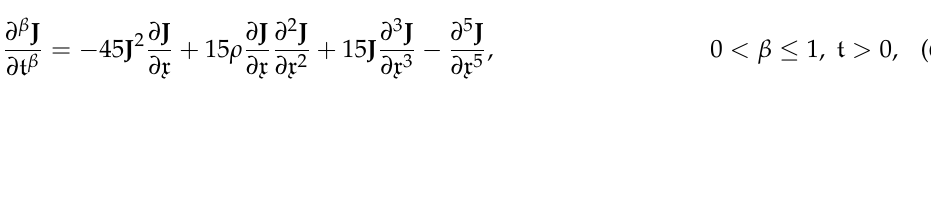
Figure 3. 2D surface formation at different values of β in Example 3 when k = 1, t = 3. Example 4. Consider the following time-fractional Kaup–Kupershmidt